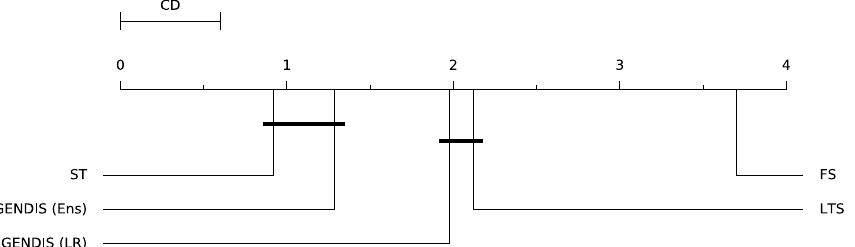
Figure 14. A critical difference diagram of the four evaluated shapelet discovery algorithms with a significance level of